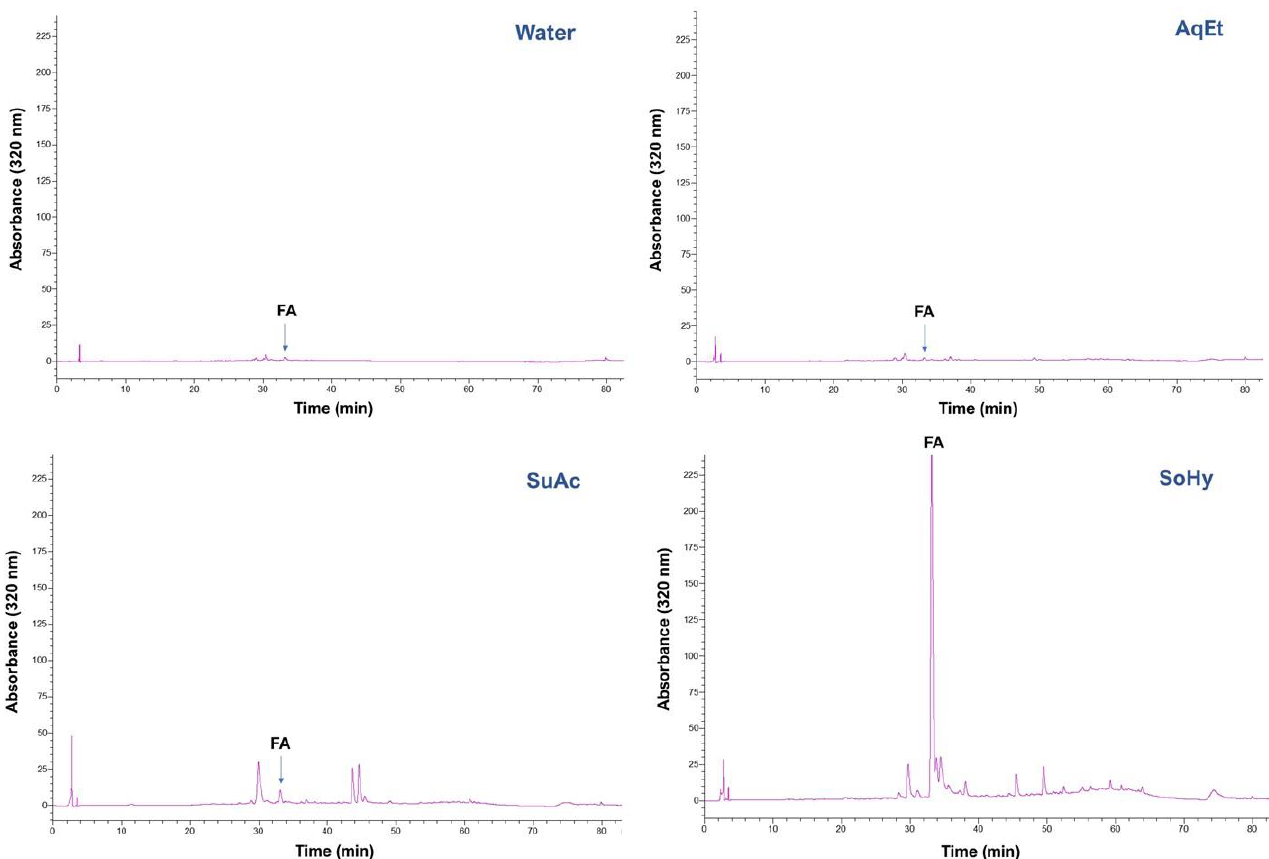
Figure 7. Representative HPLC traces recorded at 320 nm, of all the extracts tested. Water and aqueous ethanol (AqEt) extracts were used as control samples. SuAc and SoHy denote the extracts obtained with the sulfuric acid and sodium hydroxide-catalyzed process, respectively, under the conditions optimized through the response surface methodology. FA denotes ferulic acid.